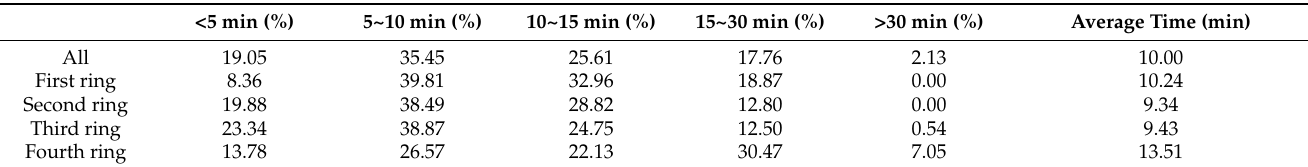
Figure 6. Accessibility measurement after adding 60 new healthcare centers (created by the authors). Table 5. Medical service coverage statistics at different time thresholds within the ring roads with the addition of 60